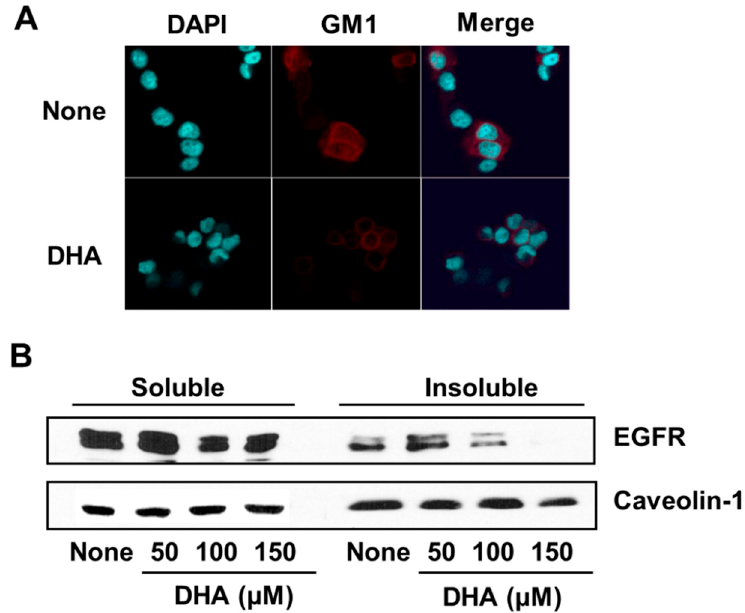
Figure 4. The effect of DHA on monosialotetrahexosylganglioside (GM1) and EGFR levels in the lipid rafts of PANC-1 cells. Cells were treated for 4 h with 150 μ M DHA ( A ) or the indicated concentrations of DHA ( B ). ( A ) Confocal microscope images. Fixed cells were stained with Alexa-fluor 555-conjugated cholera toxin subunit B (CTB-555) to identify the GM1 of lipid rafts, and with 4 ′ ,6-diamidino-2-phenylindole (DAPI) to locate the nucleus. The row of images labeled “None” corresponds to the extract from untreated cells and that labeled “DHA” to the extracts of cells treated with 150 μ M DHA. ( B ) Western blot detection of EGFR associated with the soluble vs. insoluble fractions of PANC-1 cellular membranes generated using the detergent Triton X-100. Caveolin-1 was used as a marker for the plasma membrane. The column labeled “None” corresponds to the extract from untreated cells, and the columns labeled “50”, “100”, and “150” correspond to the extracts of cells treated with 50, 100, and 150 μ M DHA, respectively.